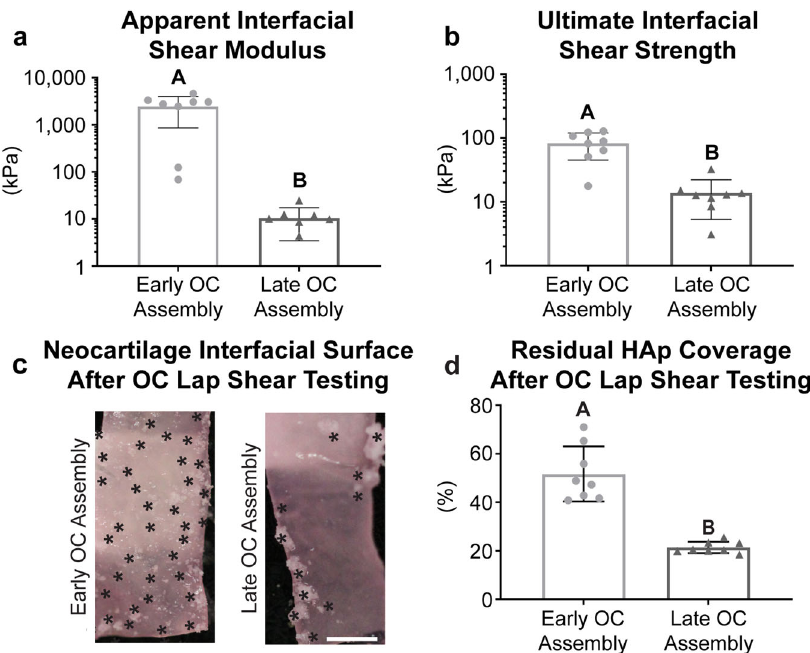
Fig. 6 Osteochondral interfacial mechanical properties at the end of 5 weeks of culture. The ( a ) apparent interfacial shear modulus and ( b ) ultimate interfacial shear strength of the neocartilage-HAp interface, as well as ( C ) the interfacial surface of the neocartilage after lap shear testing and ( d ) the quanti fi cation of the residual HAp coverage on the neocartilage interfacial surface after lap shear testing is shown. Black asterisks mark the locations of opaque, white residual HAp particles on the pink, translucent neocartilage. Data are presented as means with errors bars representing standard deviations. The y -axes in ( a ) and ( b ) are on a log 10 scale. Scale bar in panel ( c ) represents 2 mm. A student ’ s t -test was used to analyze the interfacial shear modulus and residual HAp coverage, while a non-parametric Mann Whitney test was used to analyze the ultimate interfacial shear modulus. OC osteochondral, HAp